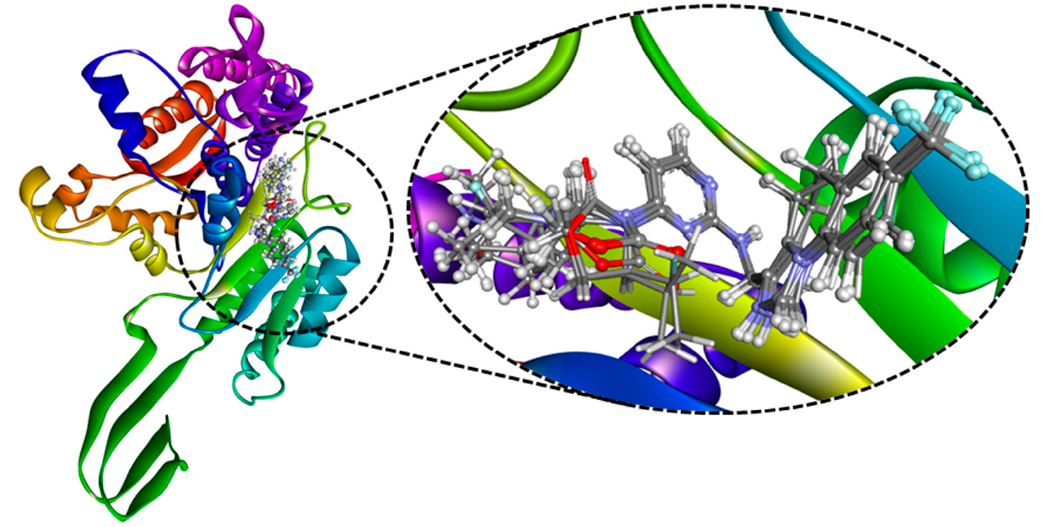
Figure 3. The cumulative picture representation of reference compound (stick model) and designed compounds (ball and stick model).